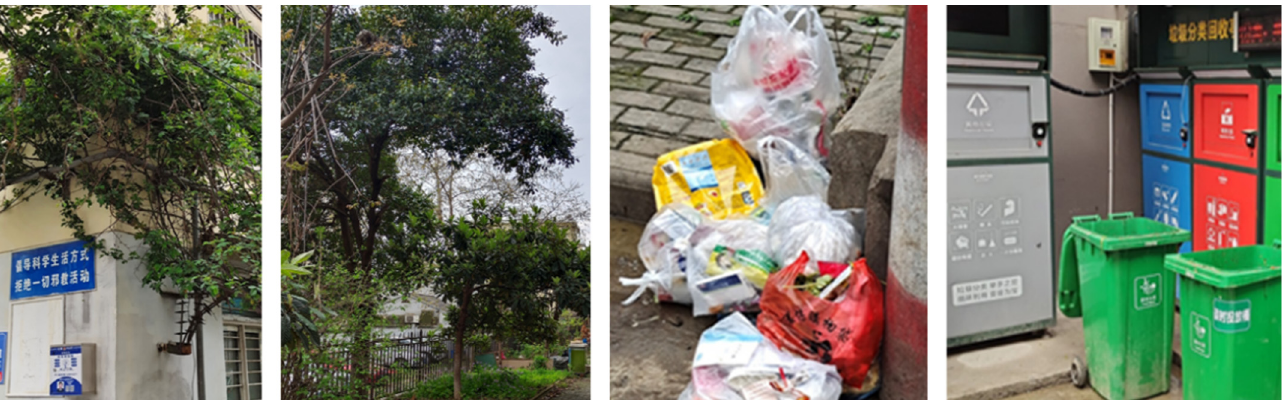
Figure 10. Public environment of the unit (photographed by Yuxin Xu in 2022). 4.1.2. Activities Through our interactions with older adults and property managers, older adults would socialize, play card games, and play chess. They would also actively engage in square dancing in the evening. Furthermore, the interior of the district has a gallery pavilion with a certain degree of privacy, allowing older adults to enjoy peace and quiet. The pavilion is surrounded by a pond lush vegetation, resulting in no space is available for studying or reading.